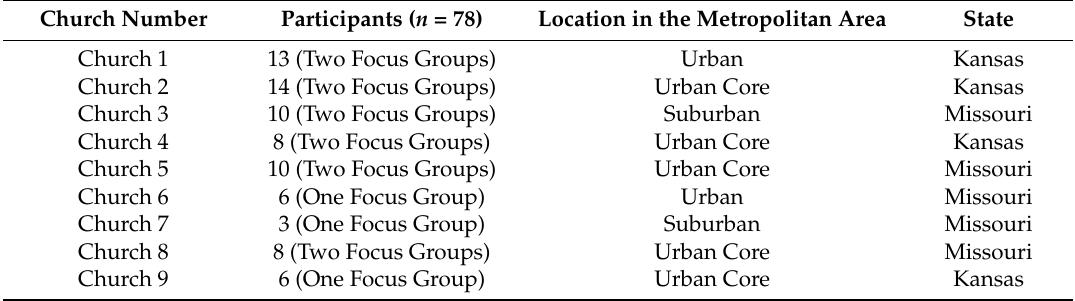
Table 1. Sample Faith Based Organizations (location and number of participants per